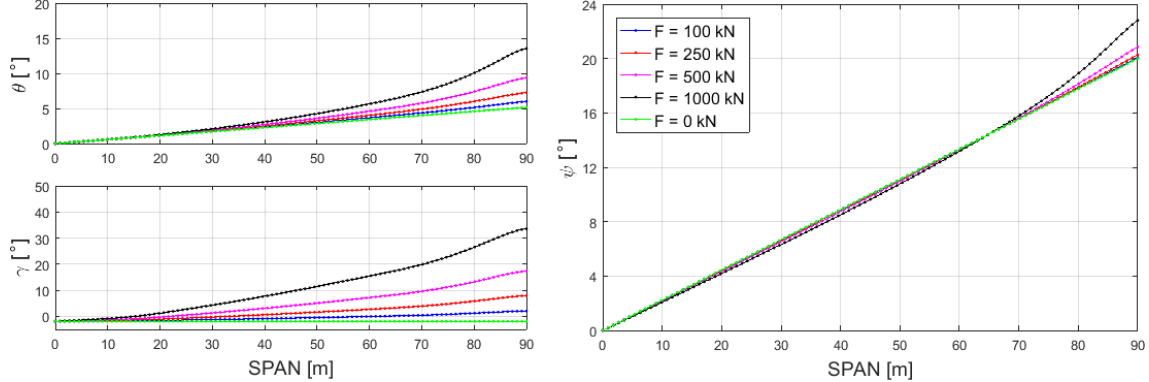
Figure 9. Local frame orientations in terms of Euler angles before (green lines) and after